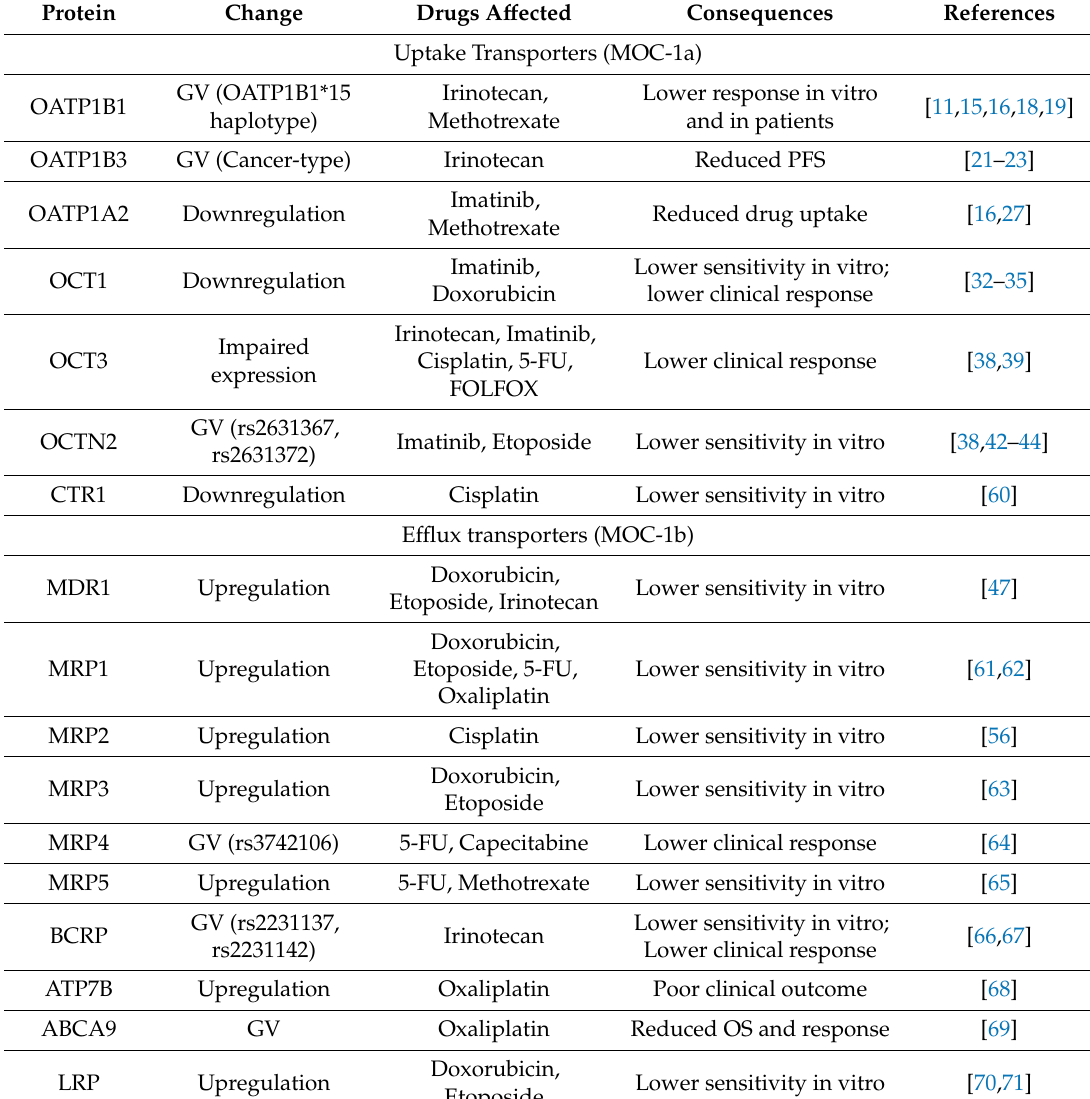
Table 1. Mechanisms of chemoresistance type 1 (MOC-1) in colorectal cancer. Protein Change Drugs A ff ected Consequences